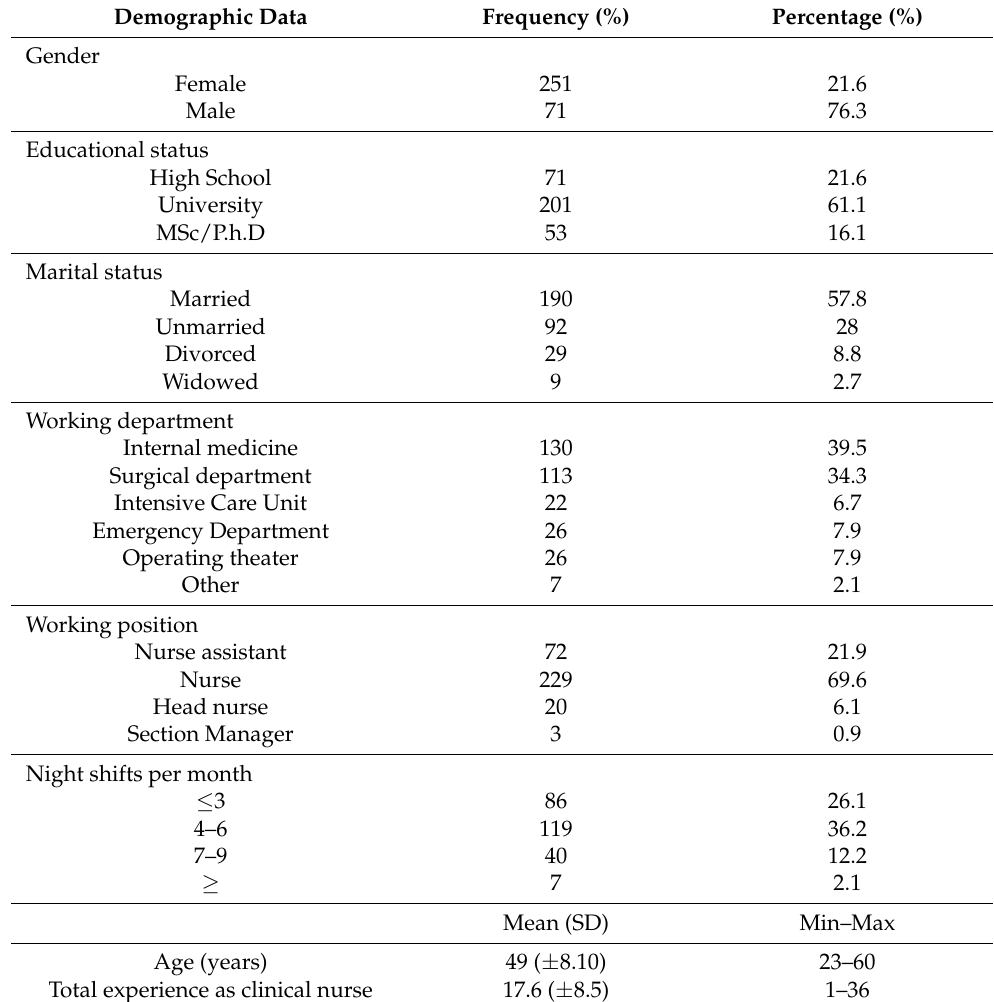
Table 2. Nurses’ sociodemographic characteristics (N = 329).